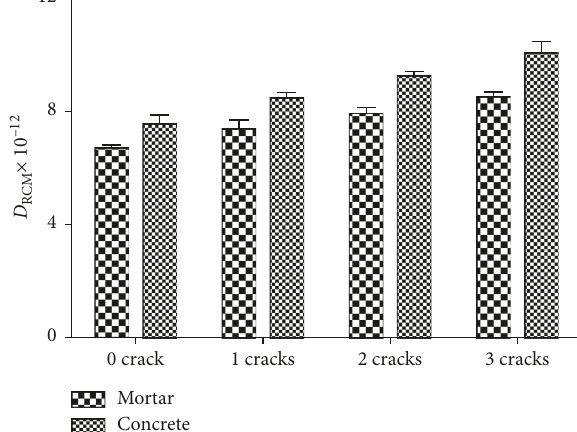
Figure 5: Chloride penetration coefficient for mortar and concrete materials (m 2